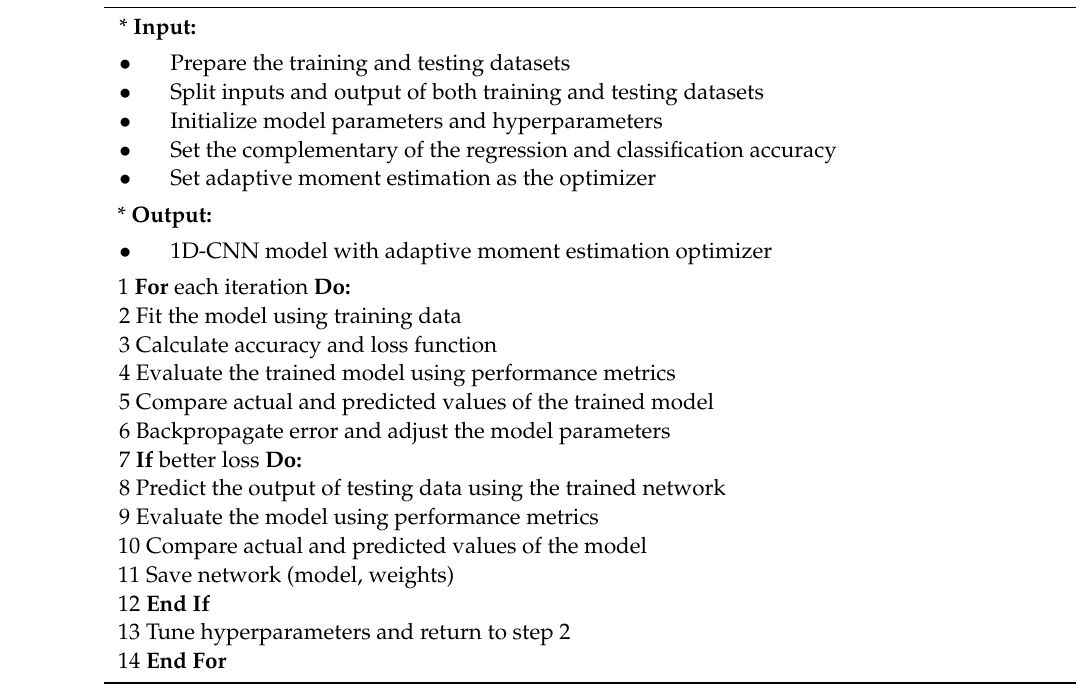
Algorithm 1 1D-CNN modelling